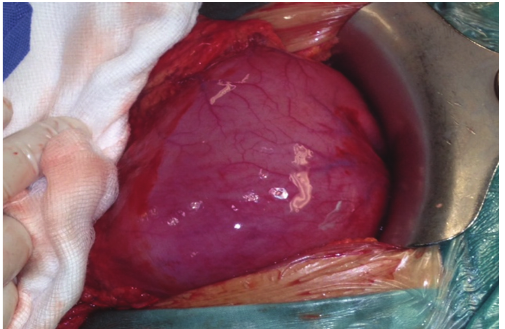
Figure 4: The untwisted distended stomach with ischemic mucosal lesions.